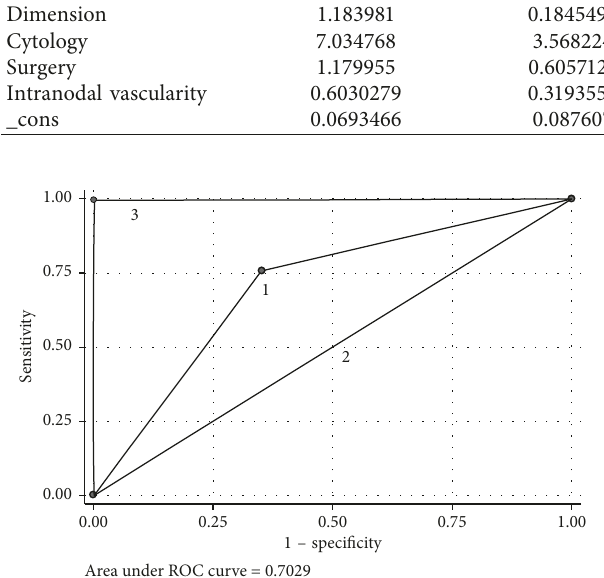
Figure 2: ROC curve of 2014 ICCRTC subclassification. (1) Ac- curacy of 2014 ICCRTC subclassification. (2) Reference line, corresponding to a useless test. (3) Excellent accuracy.